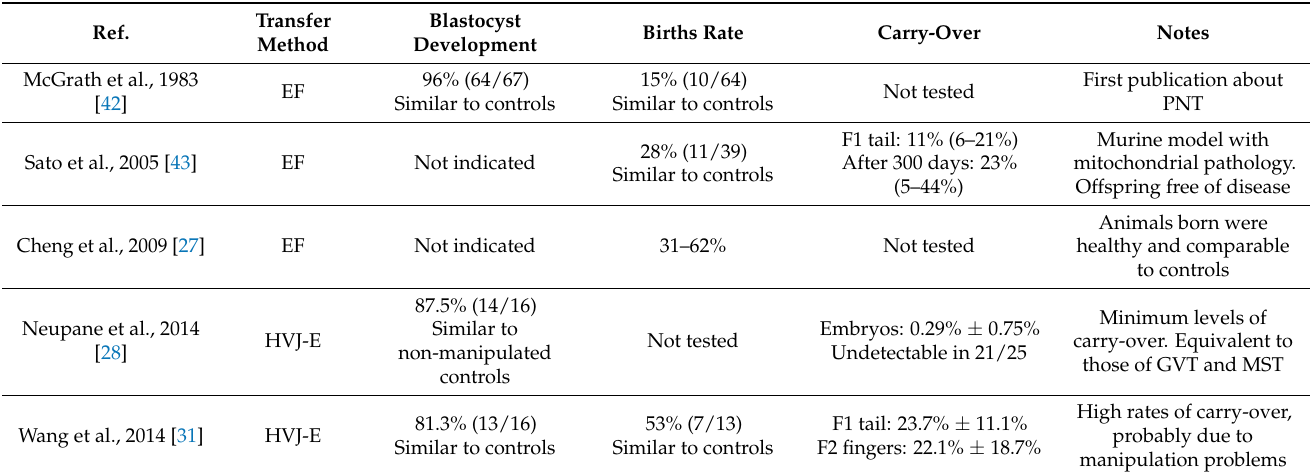
Table 5. Results of PNT in mice.